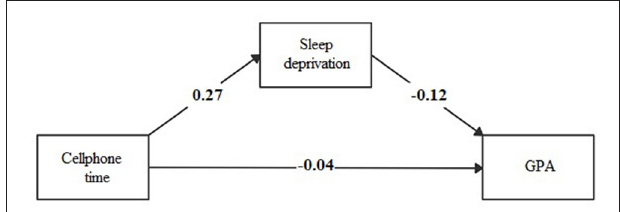
FIGURE 3 | Mediation model of sleep deprivation in the association between time spent during weekends using cellphone and academic performance